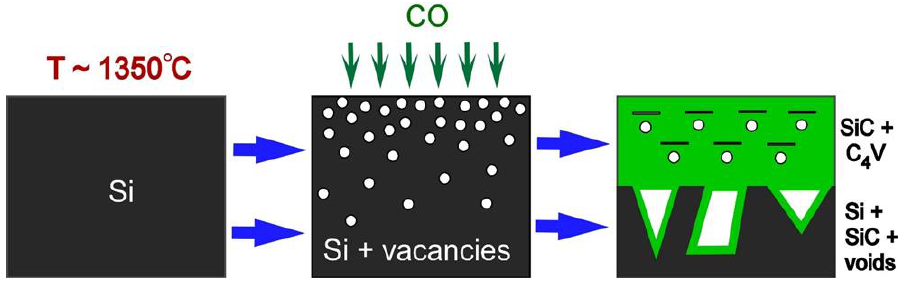
Figure 1. Schematic representation of the transformation of silicon with vacancies into silicon carbide with silicon vacancies. In the case of intrinsic SiC or p-type SiC at high temperatures, metastable silicon vacancies transform into a stable configuration with a solid-state spin: an almost flat cluster of 4 carbon atoms and, under it, a void denoted as C 4 V.